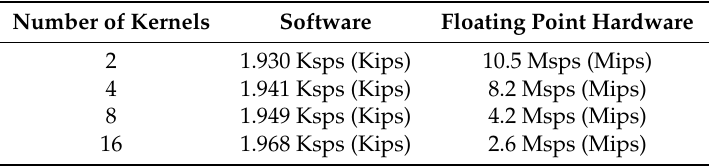
Table 3. Throughput, th , of the XOR gate dataset—floating